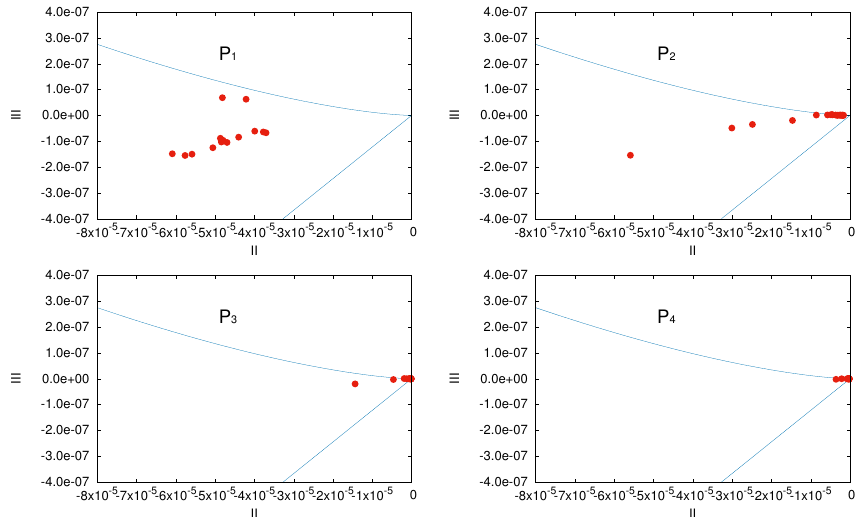
Figure 18. Isotropy diagrams by using S ij tensor invariants ( II , III ) from Equation (23). Top to bottom, left to right: Probe 1 to